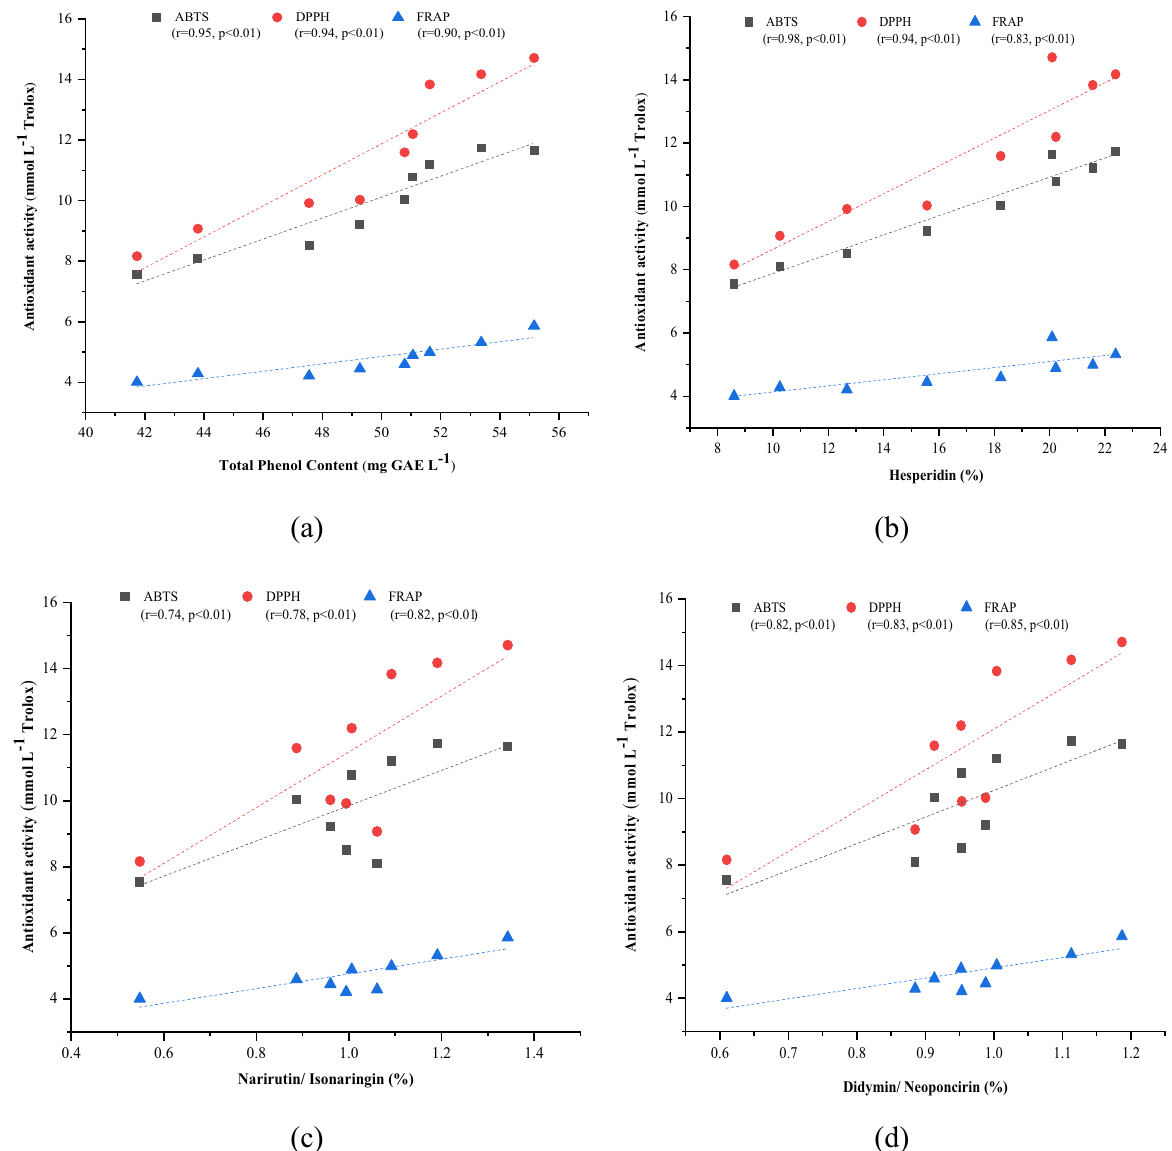
Figure 7. Graphs represent the correlation coefficient between—( a ) antioxidant capacity and Total phenol, ( b ) antioxidant capacity and hesperidin flavonoid, ( c ) antioxidant capacity and narirutin/isonaringin flavonoid and ( d ) antioxidant capacityand didymin/neoponcirin flavonoid. The correlation coefficient values obtained were significant at p <